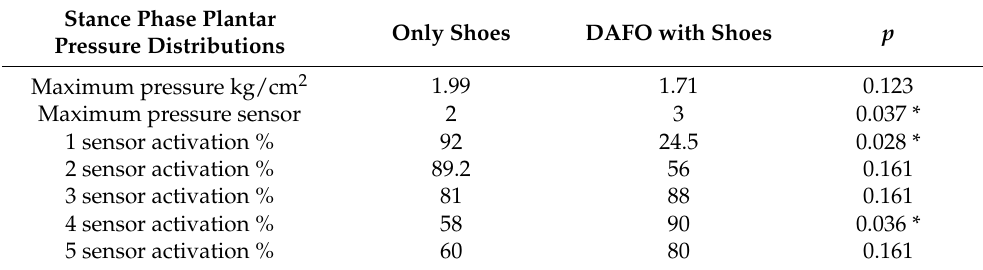
Table 2. Demonstration plantar pressure distributions on 1, 2, 3, 4 and 5 sensors maximum pressure and sensor activation % with wear-only shoes and DAFO with shoes in the stance phase (Wilcoxon signed ranks test, median values). Only Pressure Distributions